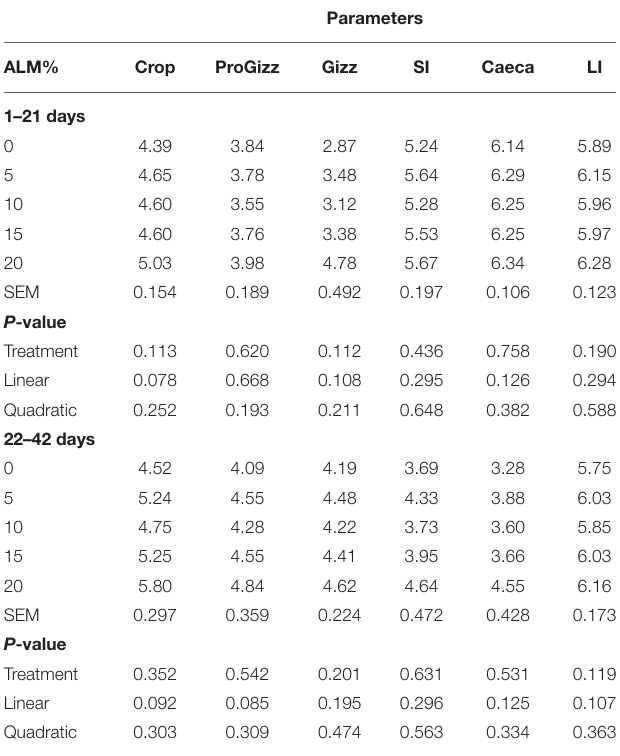
TABLE 10 | Effect of amaranth leaf meal inclusion on gut organ lengths (cm) of Ross 308 broiler chickens.